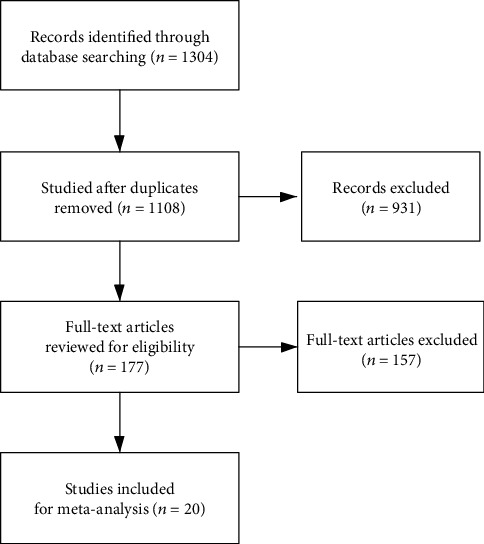
Flow diagram of the search and selection of study patients.